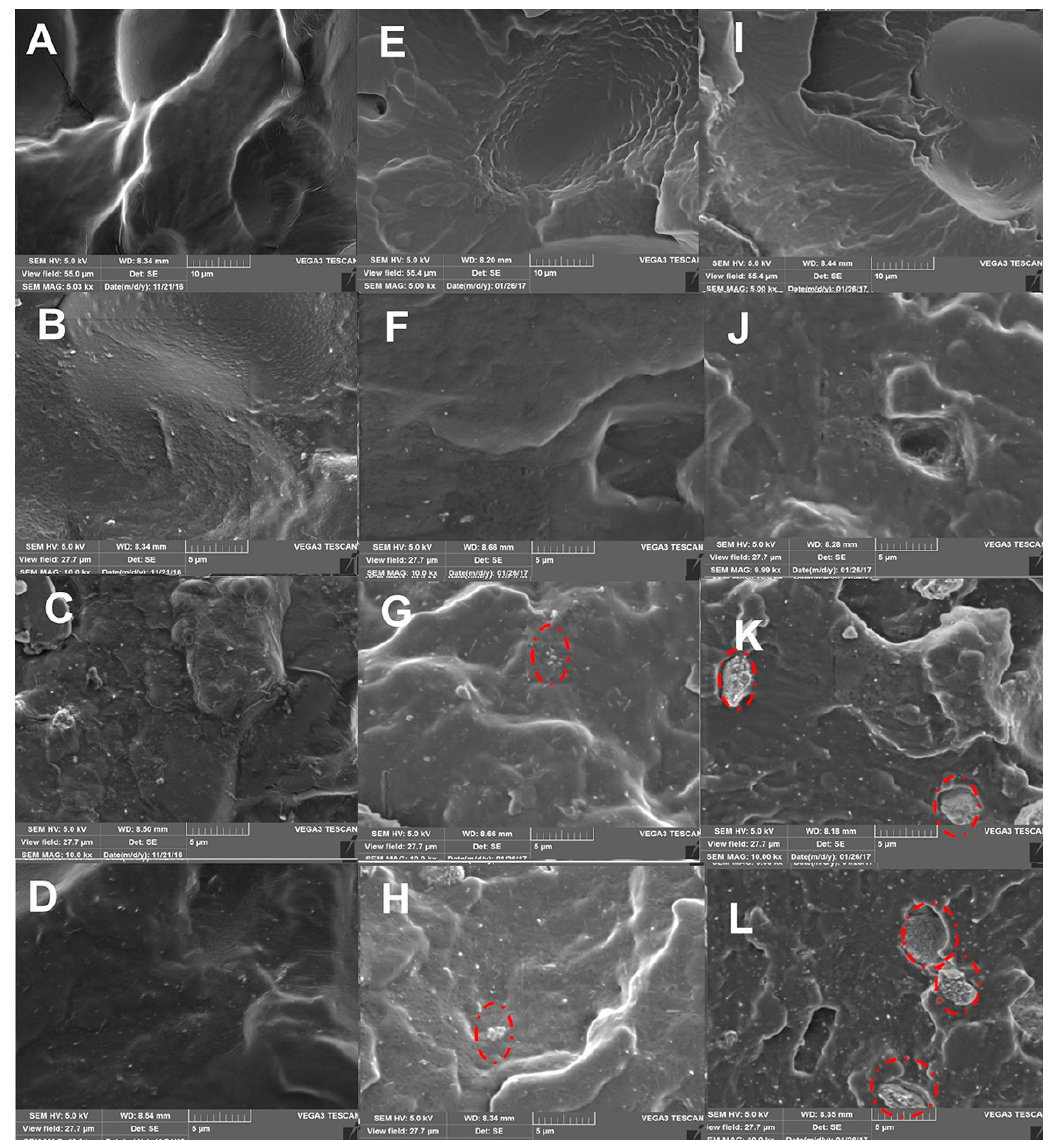
Figure 1. SEM images of the various plasticized starch systems and corresponding plasticized starch nano-biocomposites: ( A ) G0; ( B ) G3; ( C ) G5; ( D ) G7; ( E ) P0; ( F ) P3; ( G ) P5; ( H ) P7; ( I ) S0; ( J ) S3; ( K )